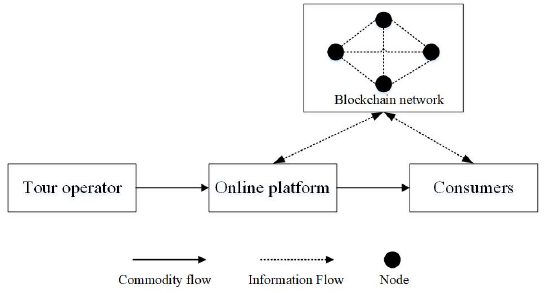
Figure 1. The structure of the tourism O2O supply chain.